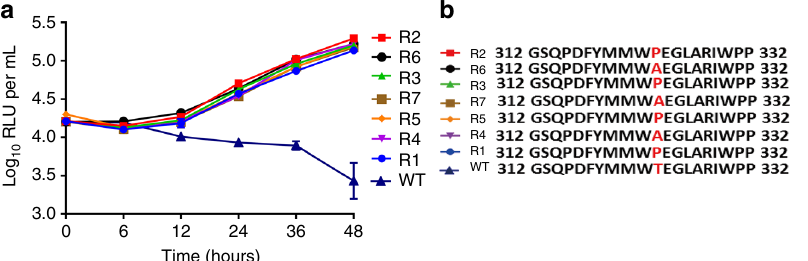
Fig. 3 Drug susceptibility testing and sequence analysis of resistant mutants. a Time-killing cures of TB47 (1 μ g mL − 1 ) against autoluminescent M. marinum resistant mutants (R1 to R7) and the parent strain in liquid culture. Data are expressed as mean ± SD from three independent biological repeats. The experiment was performed in triplicate (three independent experiments) and the representative results are shown. b Results of polymorphism in QcrB conferring resistance to TB47. WT, wild-type